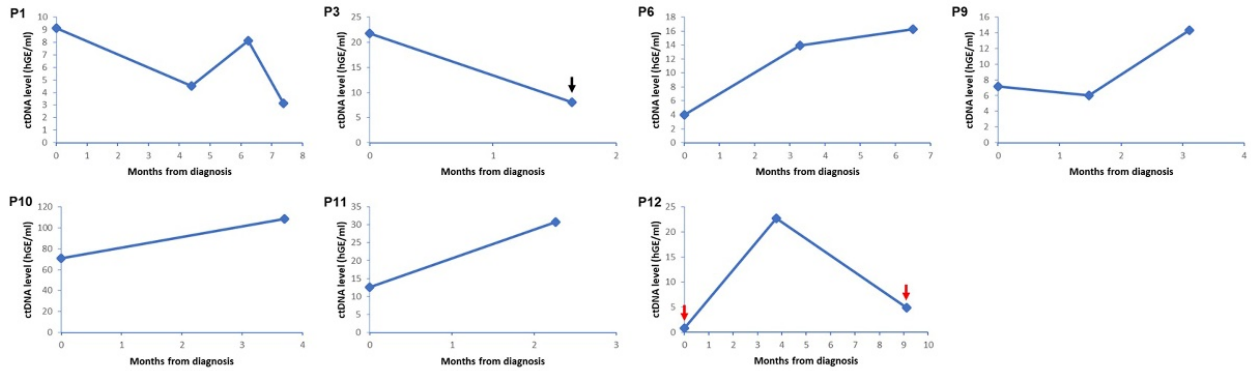
Figure 2. Changes in circulating tumor DNA (ctDNA) level of mutated gene in longitudinal plasma samples for patients with detected ctDNA. Each circle indicates a time point for plasma sampling and imaging test. In P3, the size of the primary tumor slightly increased whereas the area with tumor necrosis decreased at the second follow-up period (black arrow). In P12, pneumonia accompanied at diagnosis and the third follow-up period (red arrow).